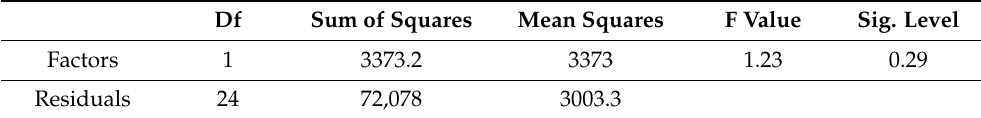
Table 3. Analysis of variance to test the impact of species.